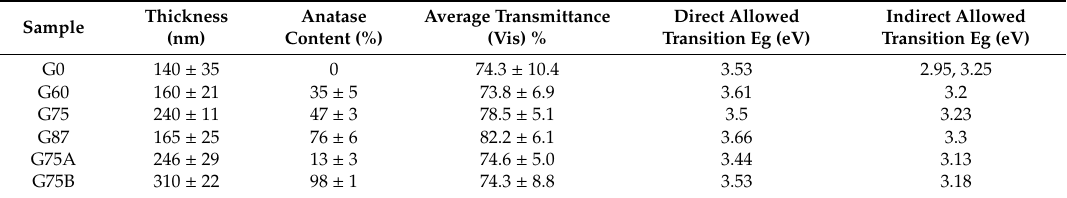
Table 2. TiO 2 thin films thickness, phase composition, % transmittance in the visible range on glass substrate and indirect / direct band